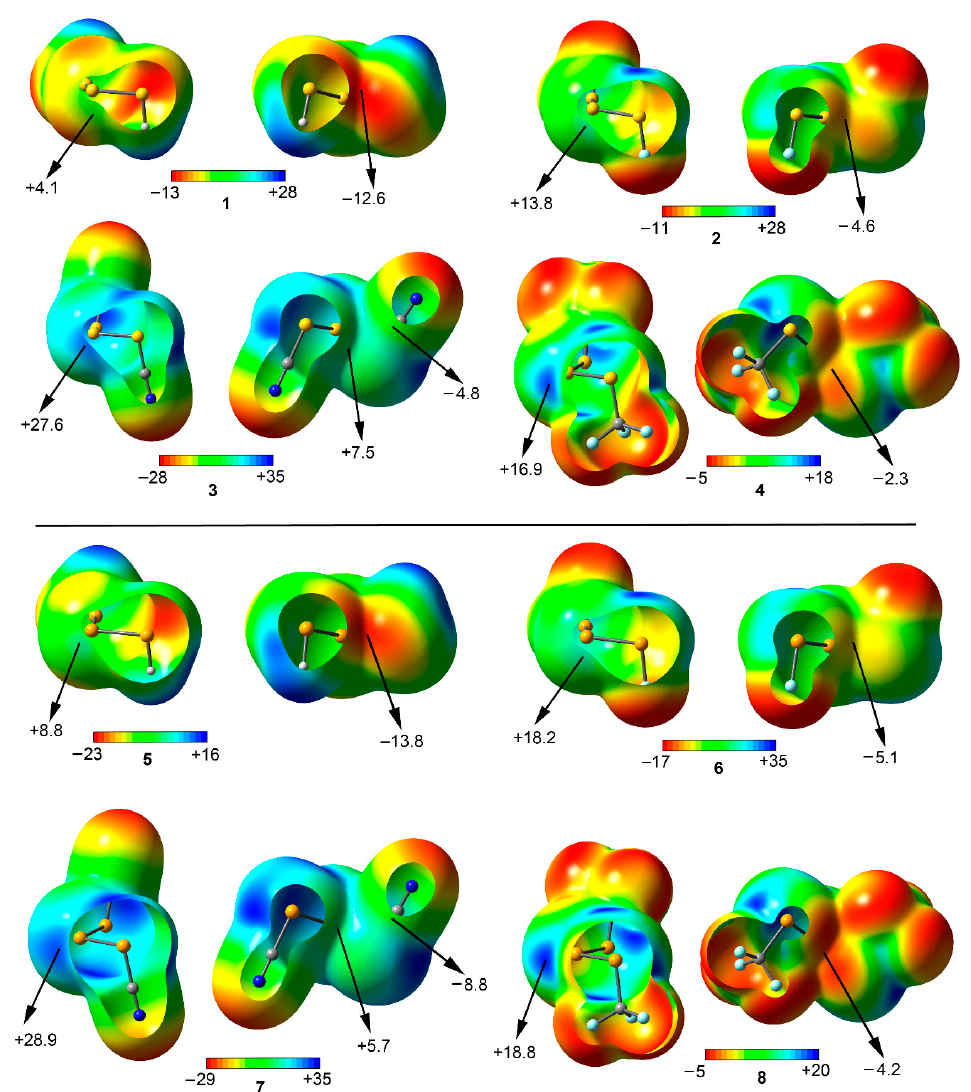
Figure 3. Molecular electrostatic potential (MEP) surfaces of compounds 1 to 8 used in the study. Energies at selected points of the surface (0.001 atomic units (a.u.)) are given in kcal/mol. Among the syn compounds ( 9 to 16 ) the σ -hole MEP values of the two vicinal S/Se atoms are positive in all cases following the behavior H < CF 3 < F < CN, similar to that observed for compounds 1 to 8 . In addition, the σ -hole MEP values for the Se derivatives ( 13 to 16 ) are more positive than the ones obtained for S compounds 9 to 12 , in agreement to that obtained for the anti set. In case of the central S/Se atom, the MEP value is negative in case of compounds 9 and 13 , however, it becomes positive when attaching a strong electron-acceptor substituent (compounds 10 to 12 and 14 to 16 ), thus expecting weaker binding energy values from an electrostatic perspective (especially in complexes involving compounds 11 , 15 , and 16 ). From the inspection of the results, complexes